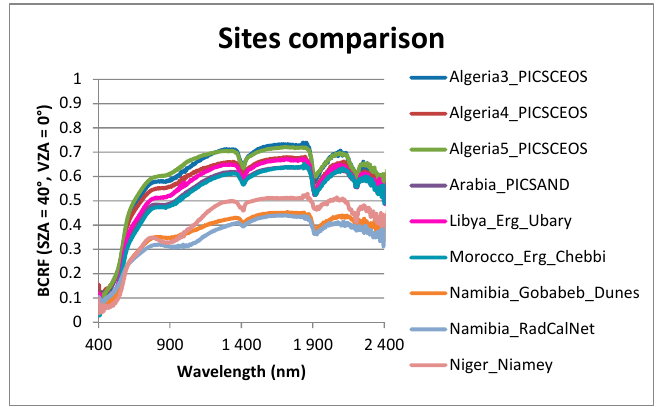
Figure 8. Spectral comparison between various sites.